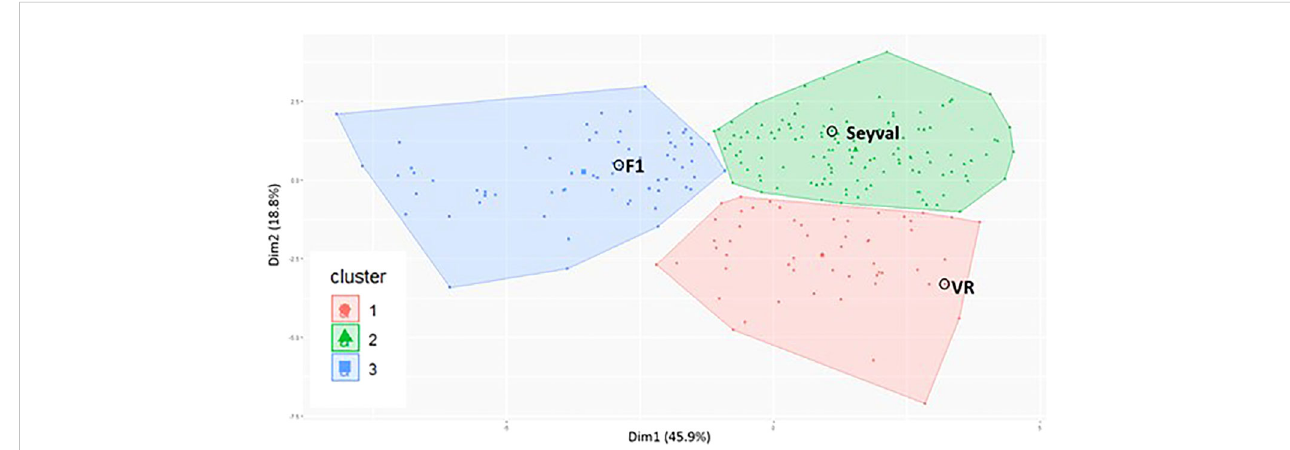
FIGURE 3 VRS-F2 population cluster plot for 14 root system traits and 2 propagule traits. Cluster plot was generated by using k-means clustering method and principal component analysis. VR indicates V. riparia ‘ Manitoba 37 ’ , Seyval indicates ‘ Seyval blanc ’ and F1 indicates the VRS-F2 population parent. Dots not circled represent VRS-F2 genotypes.